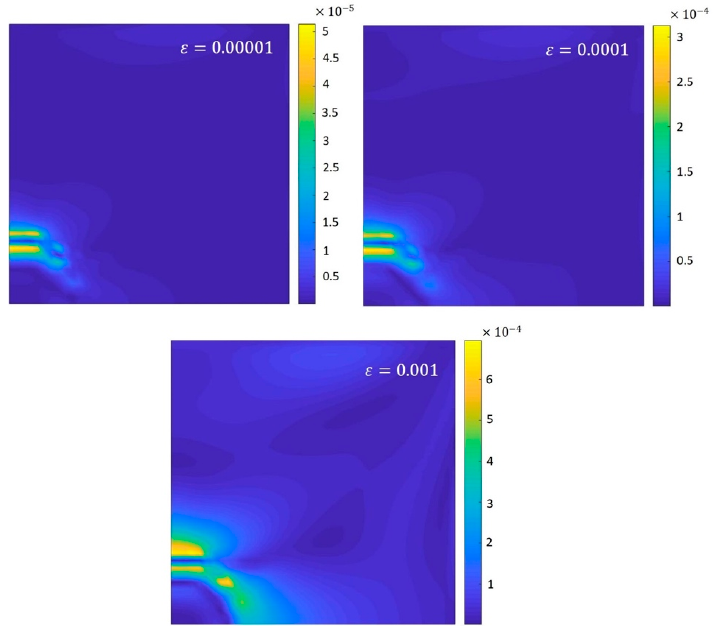
Figure 8. The magnitude of bidomain displacement, 𝐛 , for different values of 𝜀 . The fibers are horizontal.